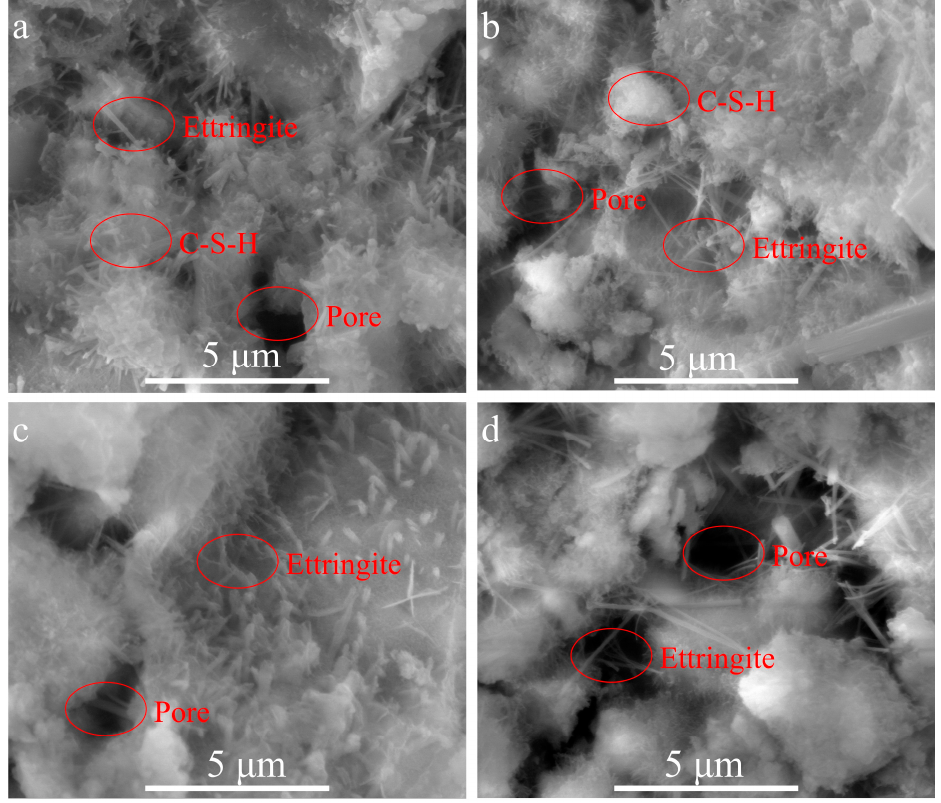
Figure 6. ESEM map of 3 d of age. ( a ) Cement; ( b ) CA20-90; ( c ) CA30-90; ( d )